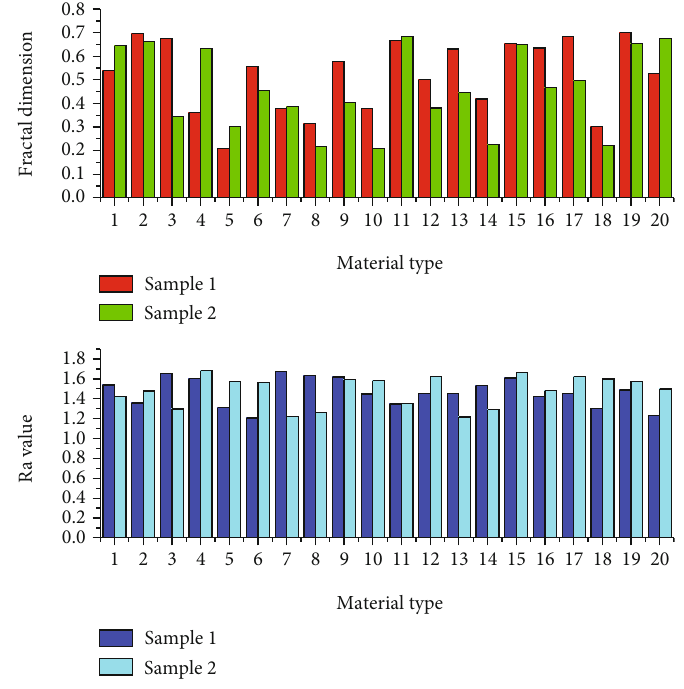
Figure 7: Roughness and fractal dimension of di ff erent